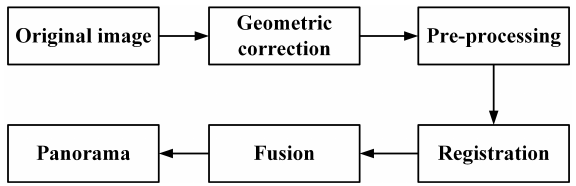
Figure 2. Main steps of the proposed